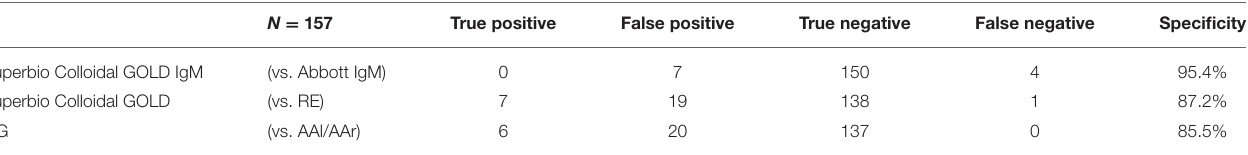
TABLE 4 | Performance of the rapid test vs. laboratory